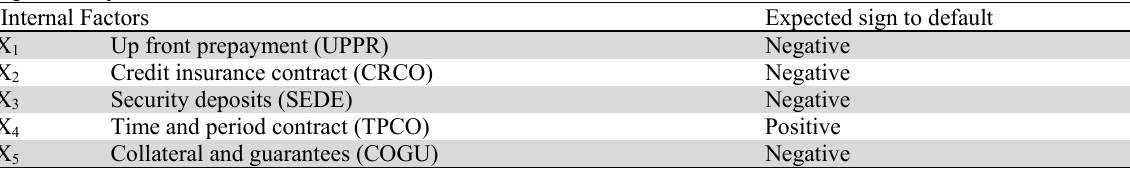
Explanatory variables Internal Factors Expected sign to